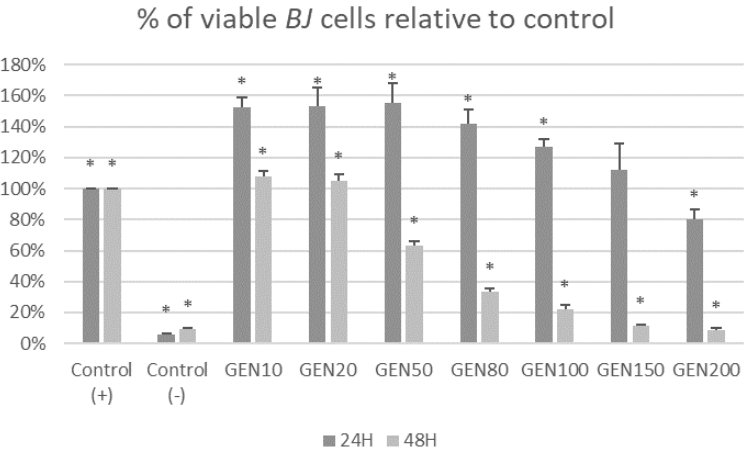
Figure 2. Cytotoxic effect of genistein at different concentrations after 24 h and 48 h on non-tumor BJ cells in MTT test. Results are the mean ± SD of n = 5. * Statistically significant ( p < 0.05; ANOVA followed by Dunnett’s test compared with control group). Cells cultured with 0.1% DMSO were considered Control (+). Cells cultured with 15% DMSO were considered as Control ( − ).